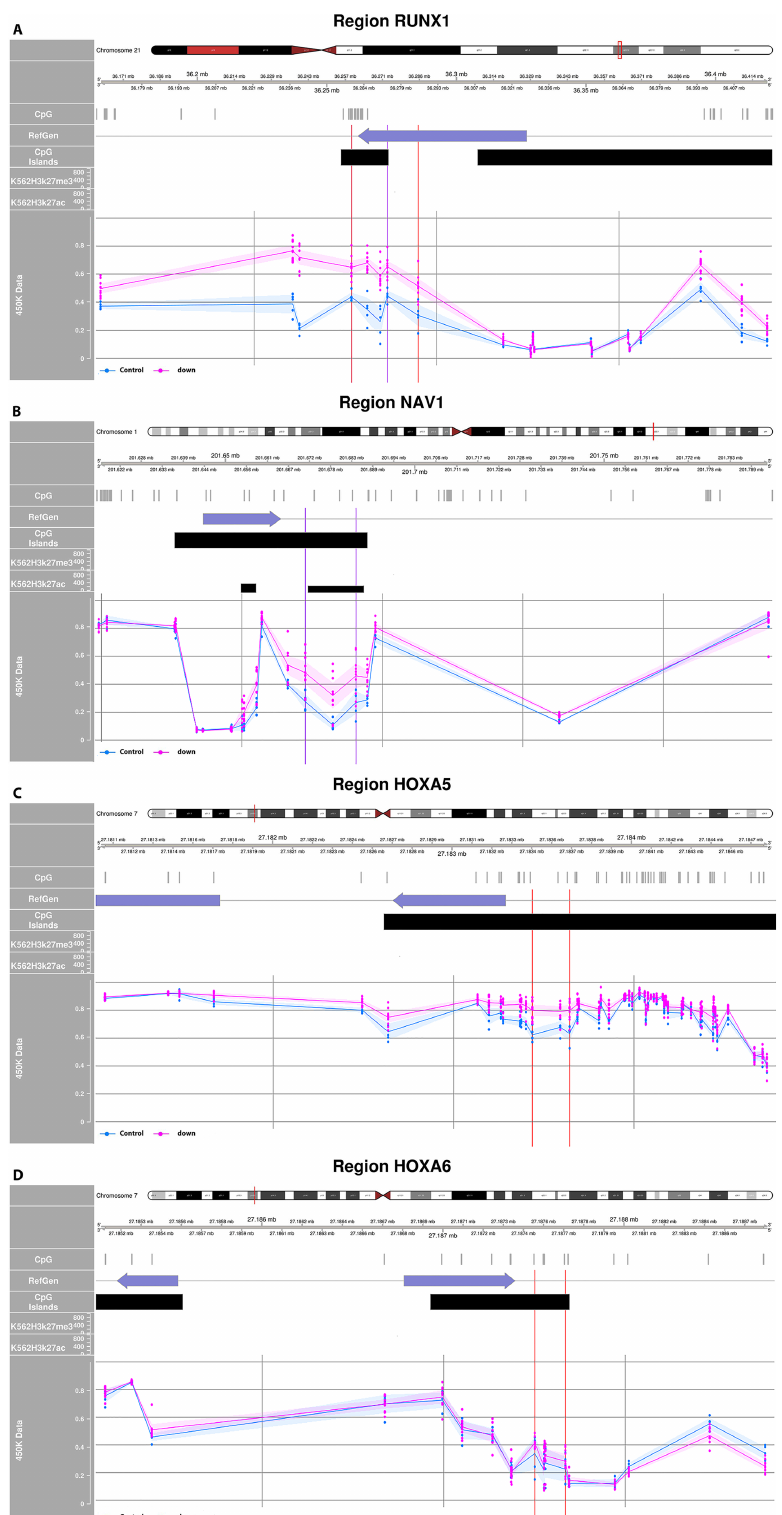
Fig 6. Regional plots of replicated DMRs. CpGs within DMRs are annotated between colored vertical lines. (A) RUNX1 , overlapping (4 of 5 probes) DMRs detected in the uncorrected and corrected model are highlighted